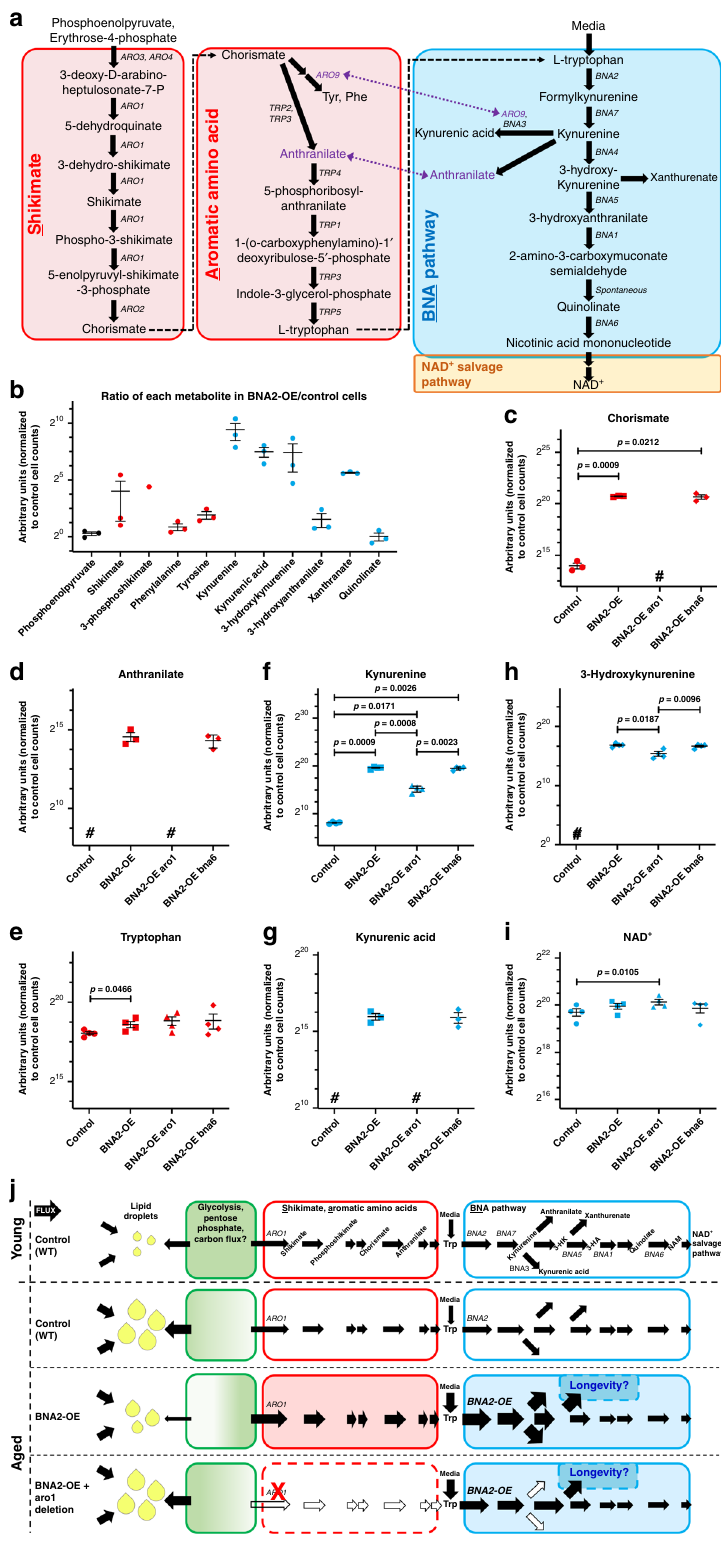
bicarbonate pH 6.8 was added to 25 mM fi nal concentration to samples, then incubated at − 20 °C for 20min. Extracts were cleared using Amicon regenerated cellulose centrifugal 10,000 NMWL centrifugal fi lters (Millipore #MRCPRT010) at 15,000 × g , 1.5h, at − 8°C. Flow-through was kept at − 70°C until analysis. Samples were dried down under nitrogen gas. Global mass spectrometry analysis using LC-MS was performed at Calico Life Sciences (Fig. 3b, Supplementary Fig. 4, Source data fi le). Samples